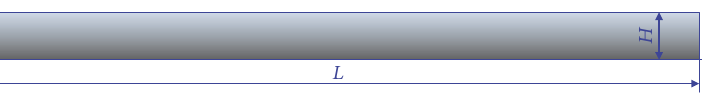
Figure 4: Geometry of an FGMEE beam and the coordinates.